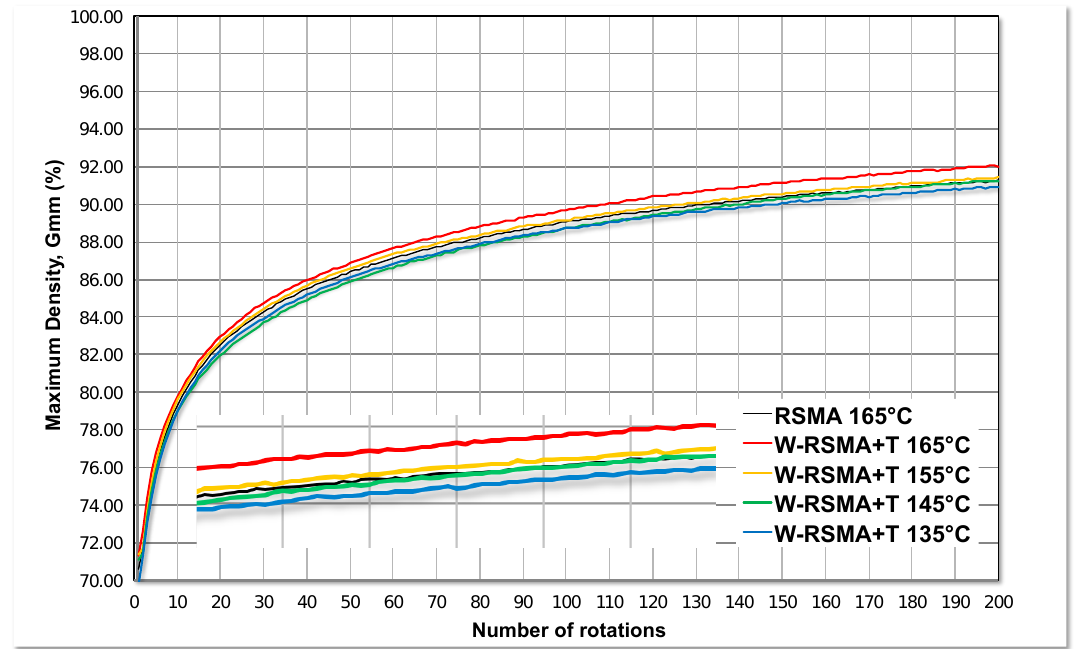
Figure 3. Compactability with the gyratory compactor and Nosbur ® ThErmo+.